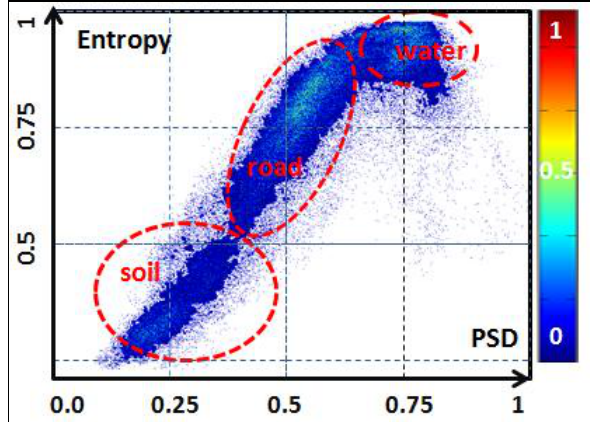
Figure 16. The normalized Entropy-PSD feature segmentation When the Entropy-PSD feature algorithm is applied, the LBO shows a remarkable distinguish in Figure.16. The further classification gives an improvement of LBO. The river/pool are separated with the road/river-wall. However, there is always some confusion when the high brightness target, such as streetlight, around the LBO. The brightness radar target is caused by the stabilized phase and that increases the randomness of surrounding PSD parameter. That is why the test site B does not present well as the test site A.